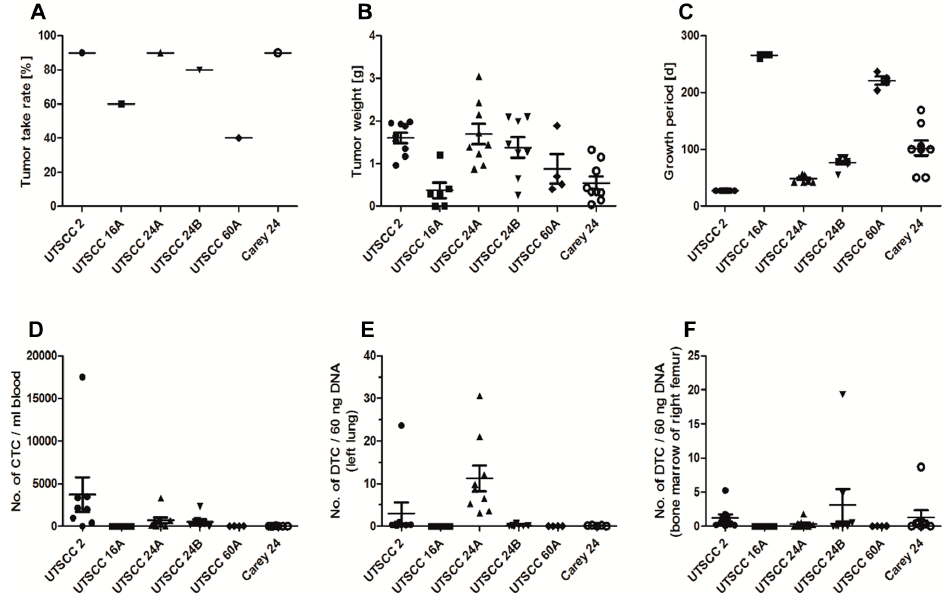
Figure 5. Vertical scatter plots with mean of primary tumor growth and metastasis of HNSCC cells in SCID mice ( UTSCC 2, UTSCC 16A, UTSCC 24A, UTSCC 24B, UTSCC 60A, o Carey 24).